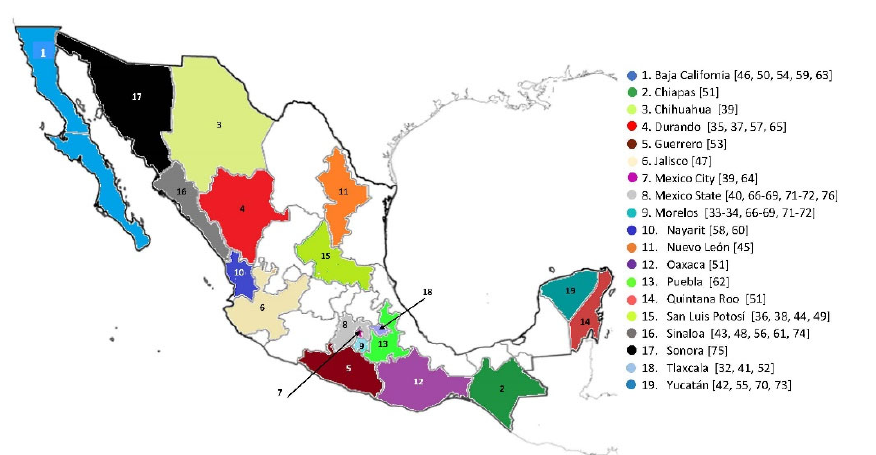
Figure 1. The map of the territories in Mexico where populations exposed to pesticides were investigated with genotoxic and related biomarkers.